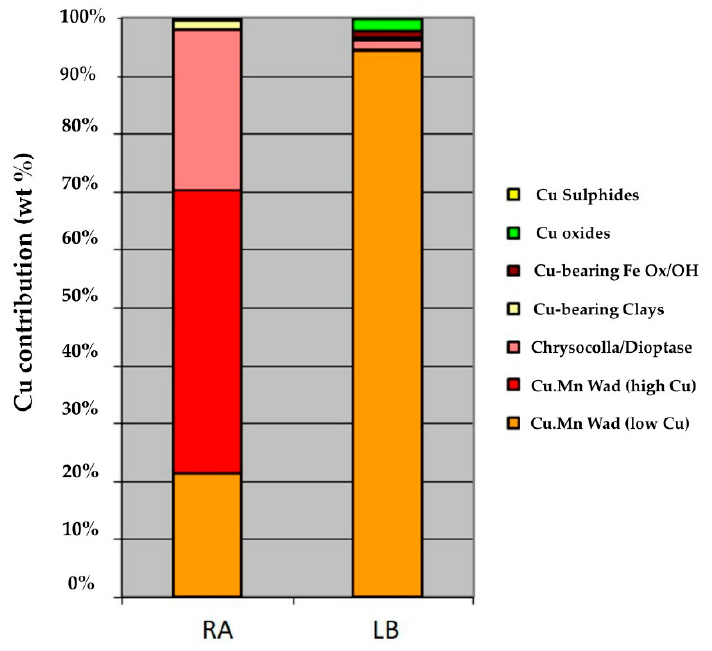
Figure 4. Cu distribution in samples RA and LB.